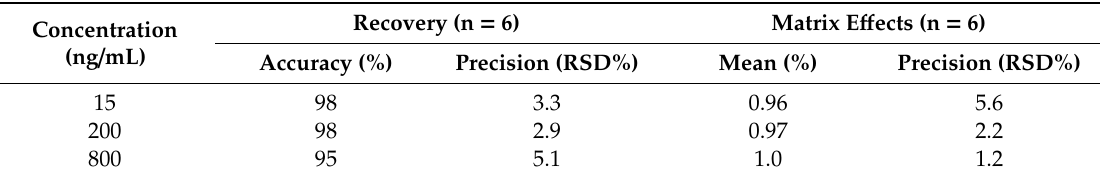
Table 2. Recovery and matrix e ff ect of lekethromycin in rat plasma.